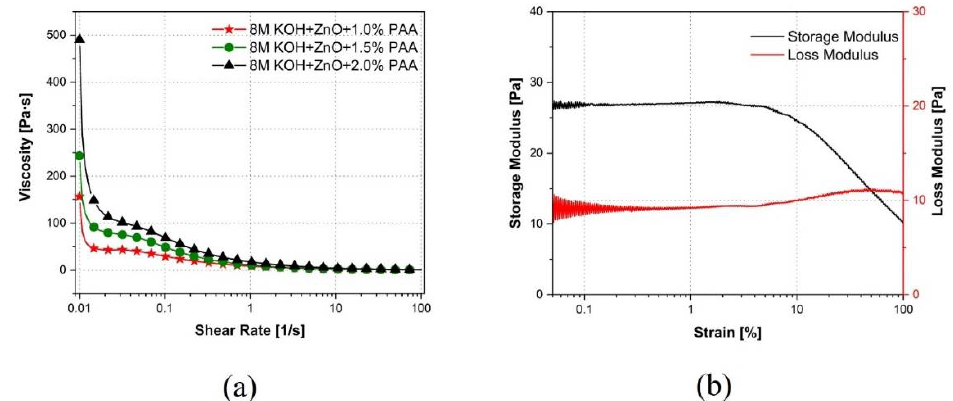
Figure 8. Effect of PAA concentration on ( a ) viscosity as a function of shear rate; and ( b ) storage and loss moduli as a function of strain.